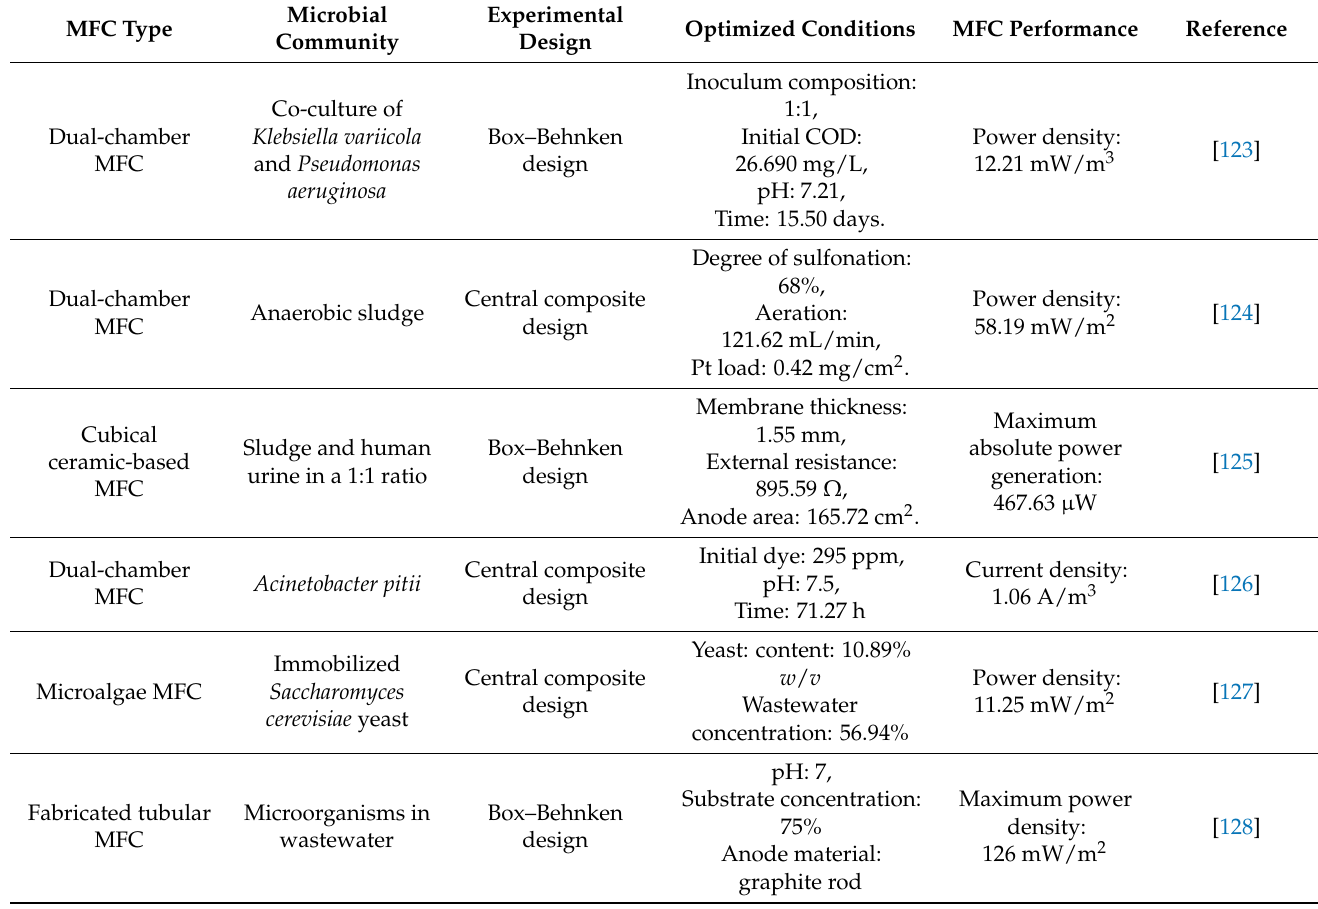
Table 1. Parametric optimization for enhancing MFC